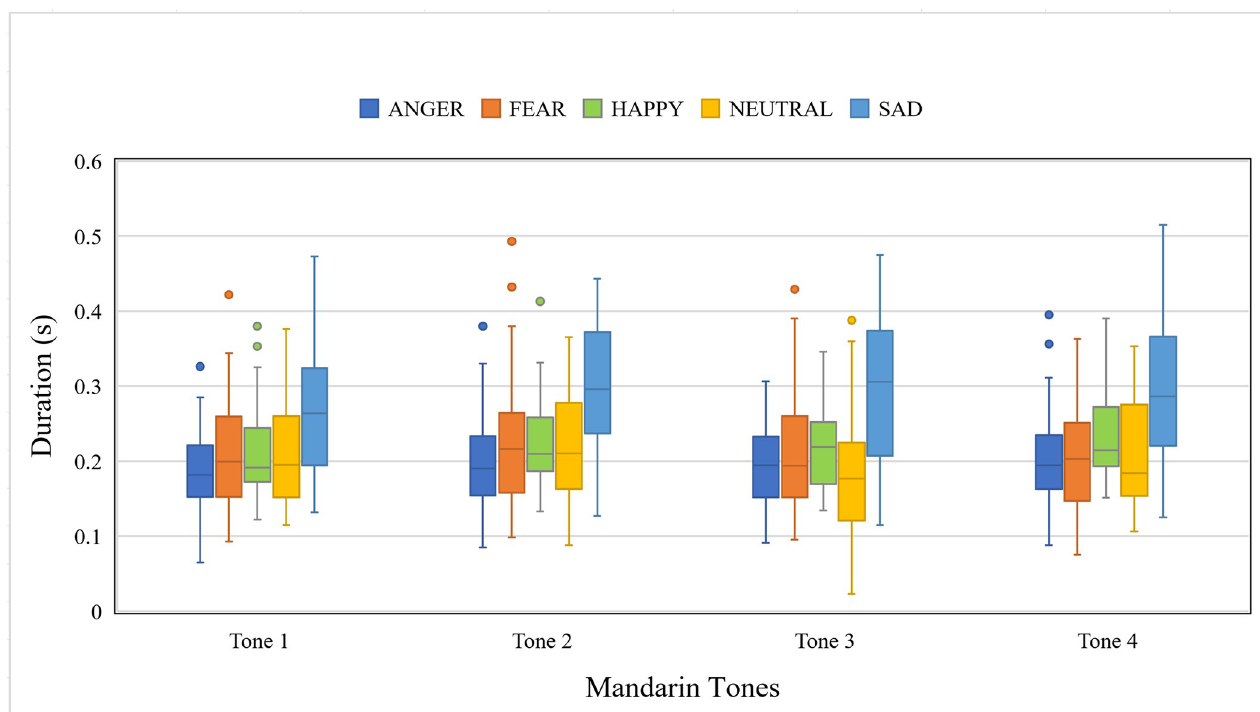
Fig 5. Boxplot showing the duration of the target syllables as a function of Mandarin tone and emotion.